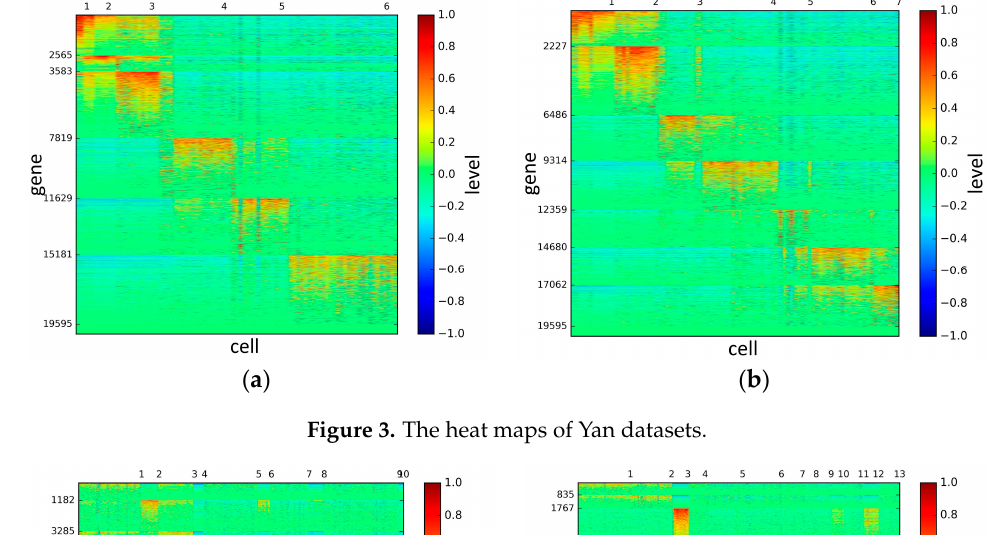
Figure 2. The heat maps of Biase datasets.